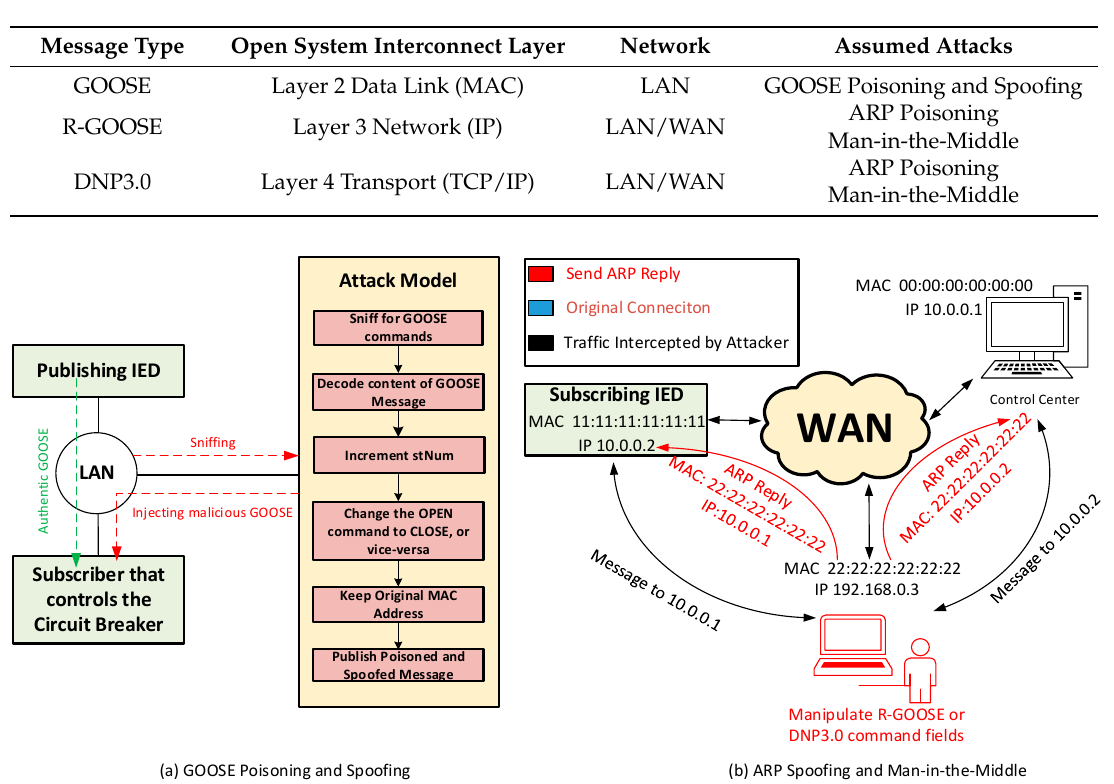
Table 1. Classification of Switching Commands and the Assumed Attacks.